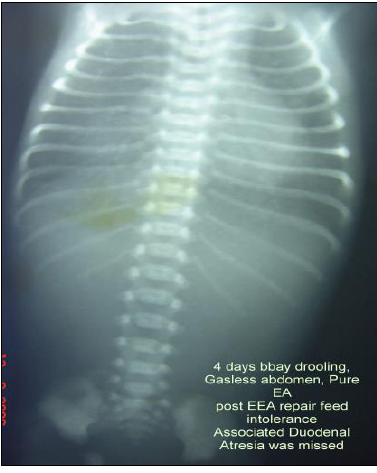
Figure 10: Gasless abdomen.